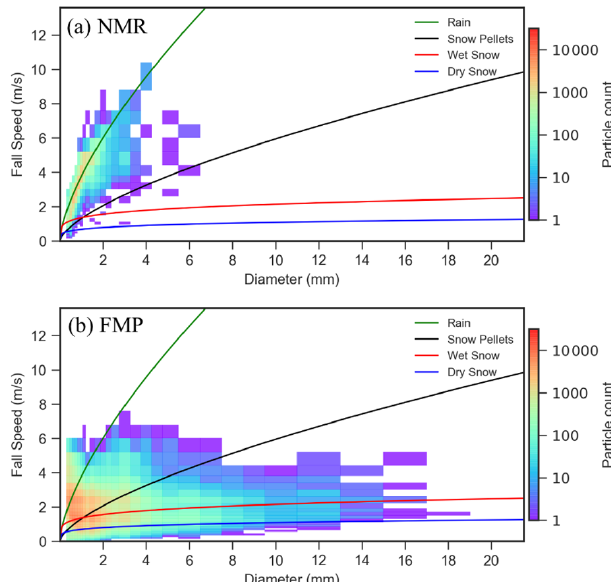
Figure 6. The particle diameter and fall speed distribution of hydrometeors measured with a laser-optical disdrometer from 17:00UTC 4 May–11:30UTC 5 May at (a) NMR and (b) FMP. Rain (green line), wet snow (red line), dry snow (blue line), and snow pellet (black line) particles. The rain fall speed–diameter re- lationship is from Atlas and Ulbrich (1977), and the solid precipita- tion is from Rasmussen et al. (1999). The number of particles that fall in each fall speed–diameter bin is indicated by the colour.